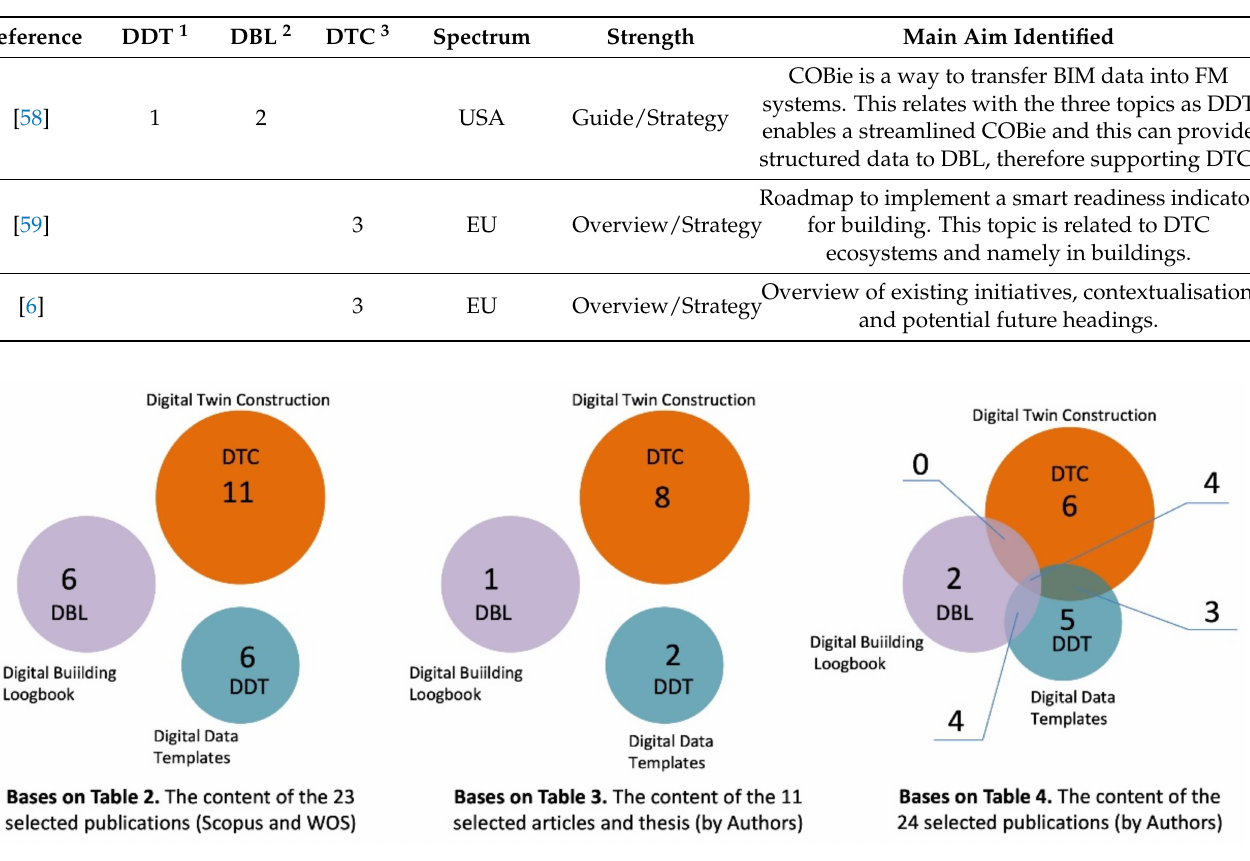
Figure 3. Visual overview on the concepts results for each one of the